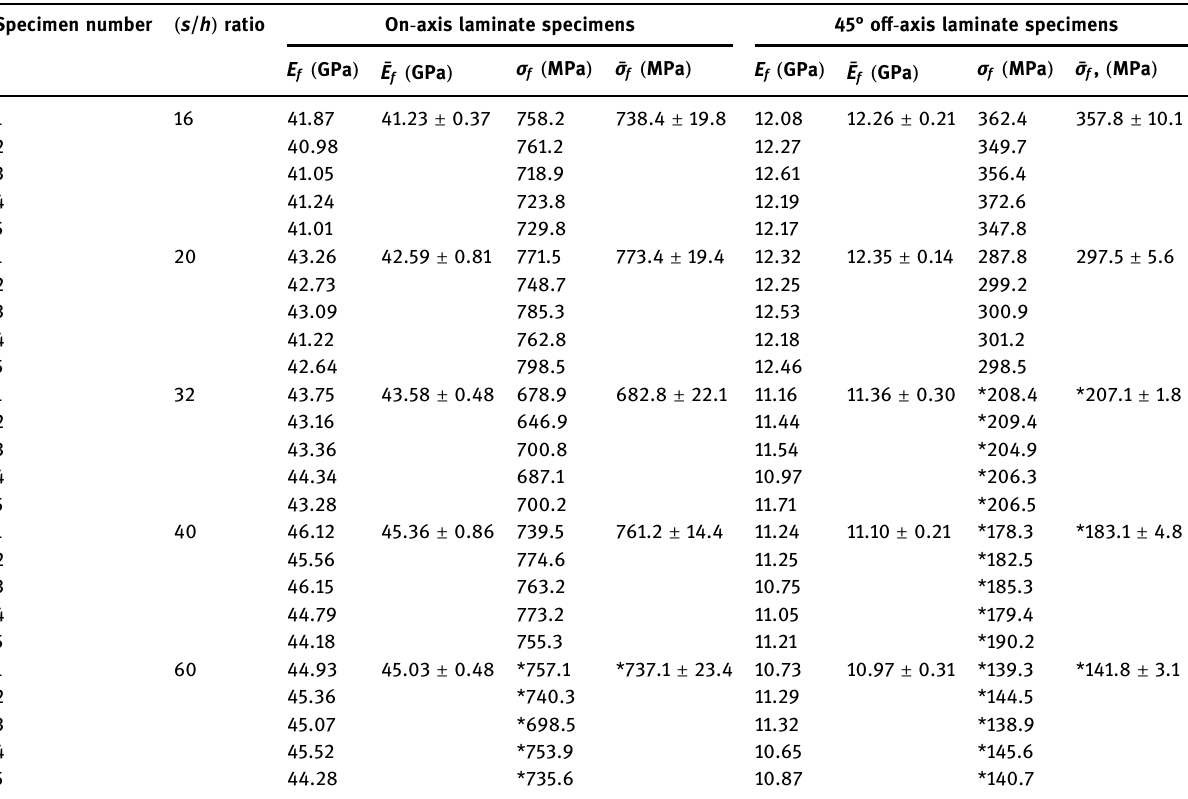
Table 2: Results of the three - point fl exure tests Specimen number ( s / h ) ratio